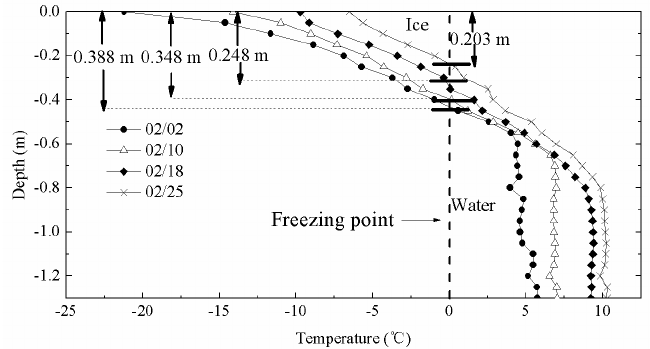
Figure 13. Temperature profiles of ice measured by Taiyuan University of Technology (TYUT) thermistor string.